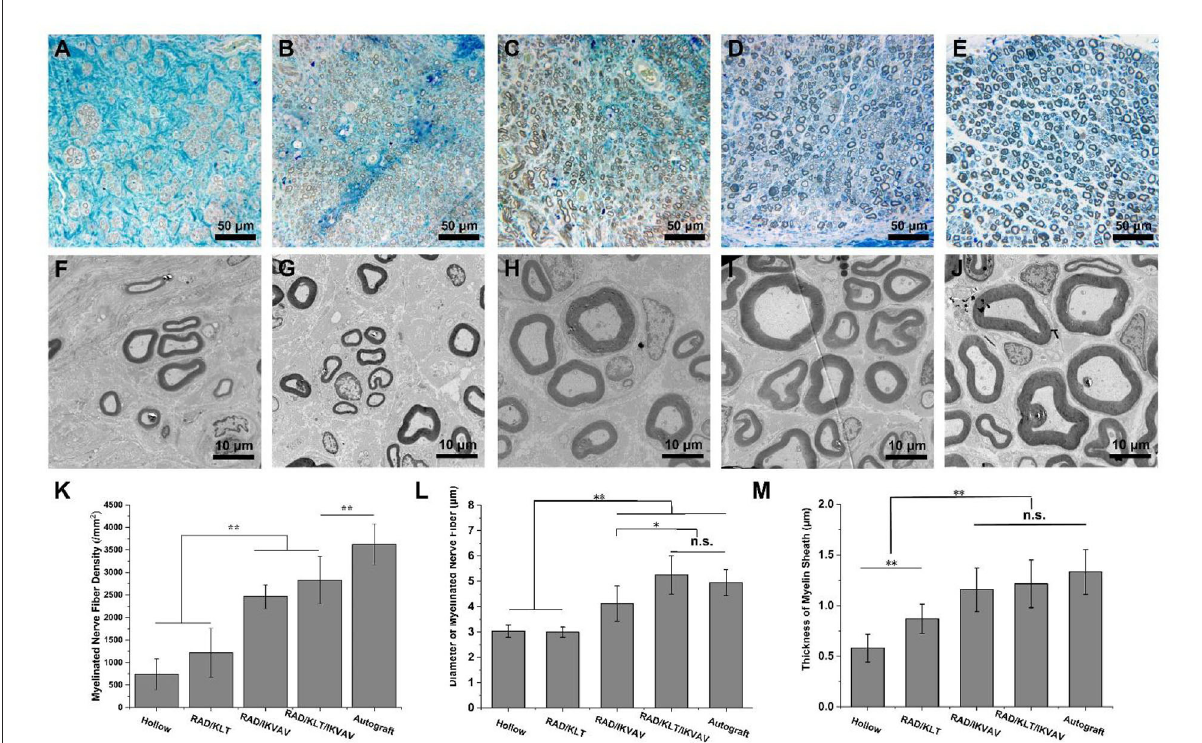
FIGURE5 Morphometric analysis of middle portions of sciatic nerves at 12 weeks after the operation. (A–E) Representative images of semi-thin transverse sciatic nerve sections from (A) Hollow group (B) RAD/KLT group (C) RAD/IKVAV group (D) RAD/KLT/IKVAV group, and (E) Autograft group (F–J) Representative images of ultra-thin transverse sciatic nerve sections from (F) Hollow group (G) RAD/KLT group (H) RAD/IKVAV group, (I) RAD/KLT/IKVAV group, and (J) Autograft group. (K) The density of myelinated axons is expressed as the number of myelinated axons per square millimeter (n/mm 2 ). (L) The diameters of myelinated axons. (M) The thickness of myelin sheath. Values represent mean ± SD; n.s. no significant difference, ** p < 0.01, * p < 0.05 in multiple comparisons between treatment groups.